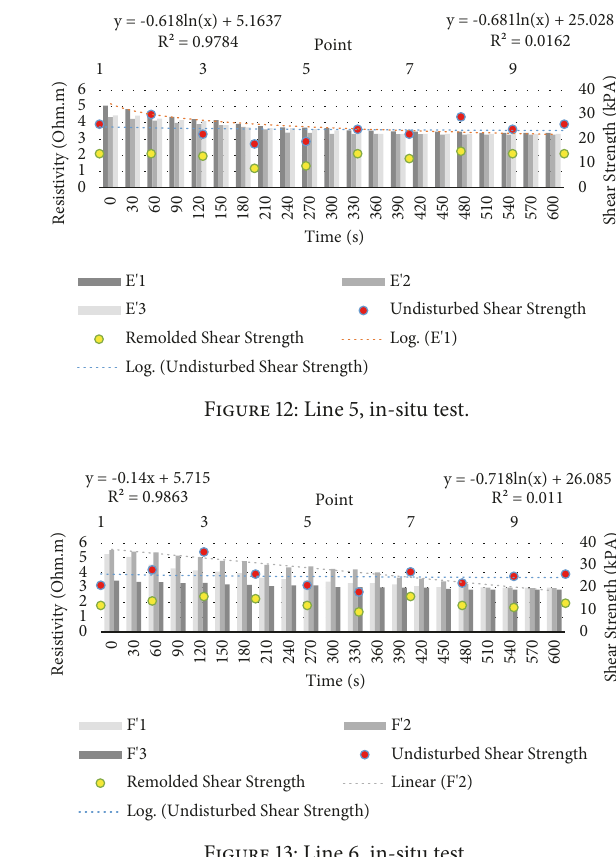
Figure 13: Line 6, in-situ